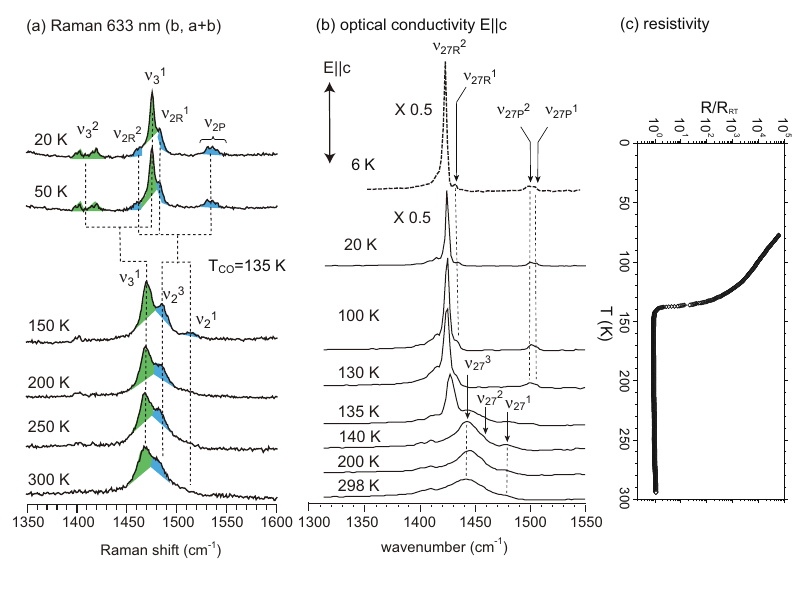
Figure 18. ( a ) Temperature dependence of the Raman spectrum of α -(BEDT-TTF) and ν modes are shown as blue and green, respectively. A drastic spectral change is ν 2 3 observed below 120 K. The difference in the transition temperature comes from the laser heating effect; ( b ) Temperature dependence of the infrared spectrum of α -(BEDT-TTF) which was obtained by the Kramer-Kronig transformation of the reflectivity polarized along the c-axis (perpendicular to the conducting plane). The 6 K spectrum drawn by the dashed line is the optical conductivity of the deuterium substituted compound, -BEDT-TTF) I ; ( c ) Electrical resistivity normalized by room temperature value. The α -(d 8 2 3 optical conductivity is taken from Figure 1 of ref.